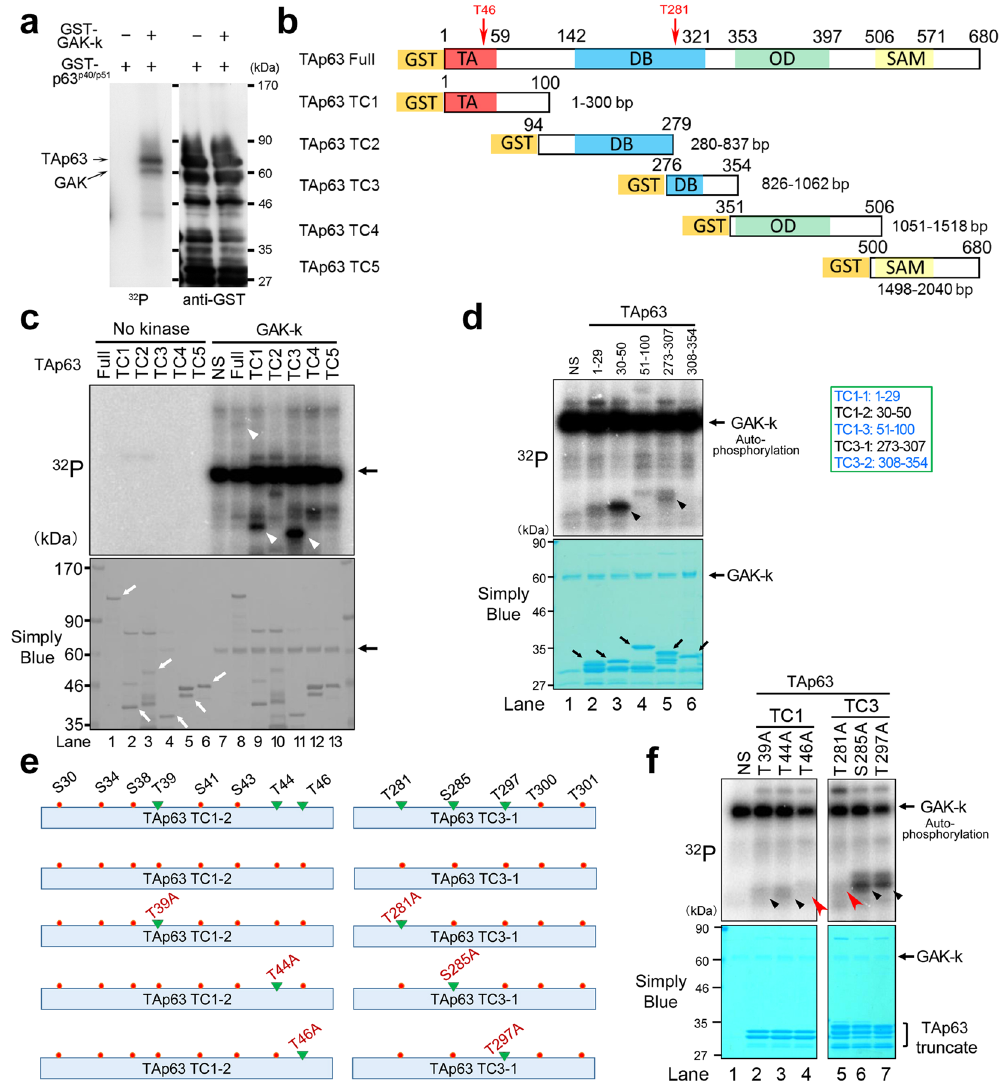
Figure 1. TAp63 is phosphorylated at T46 and T281 by GAK in vitro . ( a ) GST-p63 p40/p51 protein shows a phosphorylated band (horizontal arrow) in the presence of GST-tagged GAK-k (tilted arrow), the kinase domain of GAK. ( b ) A schematic representation of TAp63 structure and TC1–TC5 fragments denoting the sites of functional domains and amino acid numbers. TA, transactivation; DB, DNA binding; OD, oligomerization; SAM, C-terminal sterile alpha motif. ( c ) Radio-autograph of SDS-PAGE analysis after in vitro kinase assays of full-size and TC1–TC5 fragments of TAp63 in the absence (no kinase) or presence of GAK-k (horizontal arrow). White arrows denote the bands for full-size and TC1–TC5 fragments of TAp63 as stained by Simply Blue, whereas white arrowheads indicate the phosphorylated bands in the radio-autograph. Horizontal arrows denote the band for auto-phosphorylation of GAK-k. ( d ) Radio-autograph showing that TC1-2 (30–50) and TC3-1 (273–307) fragments, but not TC1-1 (1–29), TC1-3 (51–100), or TC3-2 (306–354) fragments, of TAp63 are the phosphorylation substrates of GAK-k. Black arrowheads or black arrows denote the bands for phosphorylated TAp63 fragments or GAK-k, respectively. NS, no substrate. ( e ) A schematic representation of TC1-2 and TC3-1 fragments of TAp63 that were identified as the phosphorylated substrates by GAK-k. Location of S and T residues that are possible phosphorylation targets of GAK-k are shown, together with their alanine (A) substitutes that are used as the GST-tagged substrates (green triangles). ( f ) Radio-autograph showing that the band intensities for T46A and T281A fragments were weakened (red arrowheads) due to T/A substitutions. Black arrowheads denote the phosphorylated bands for TC1-T39A, TC1-T44A, TC3-285A, and TC3-297A fragments. Horizontal black arrows denote the bands for